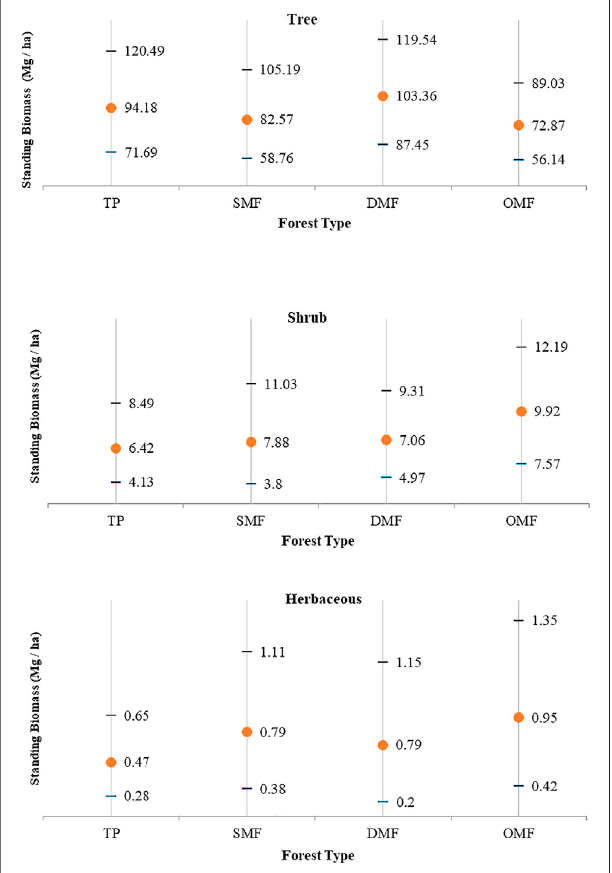
FIGURE 7 | Estimates of standing biomass with 95% C.I. of different componentsoftree,shrubandherblayersintropicalforestsofAABR(Mg/ha).